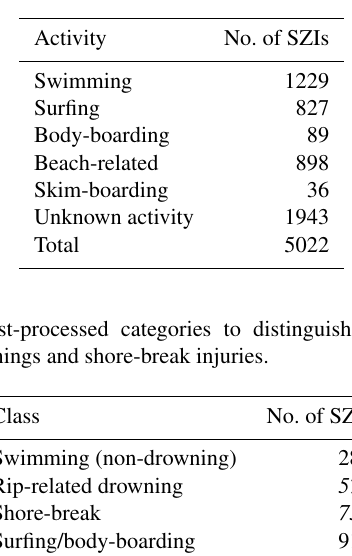
Table 1. Activity distribution SZIs as indicated in the medical files between 8 January 2011 and 18 November 2017.